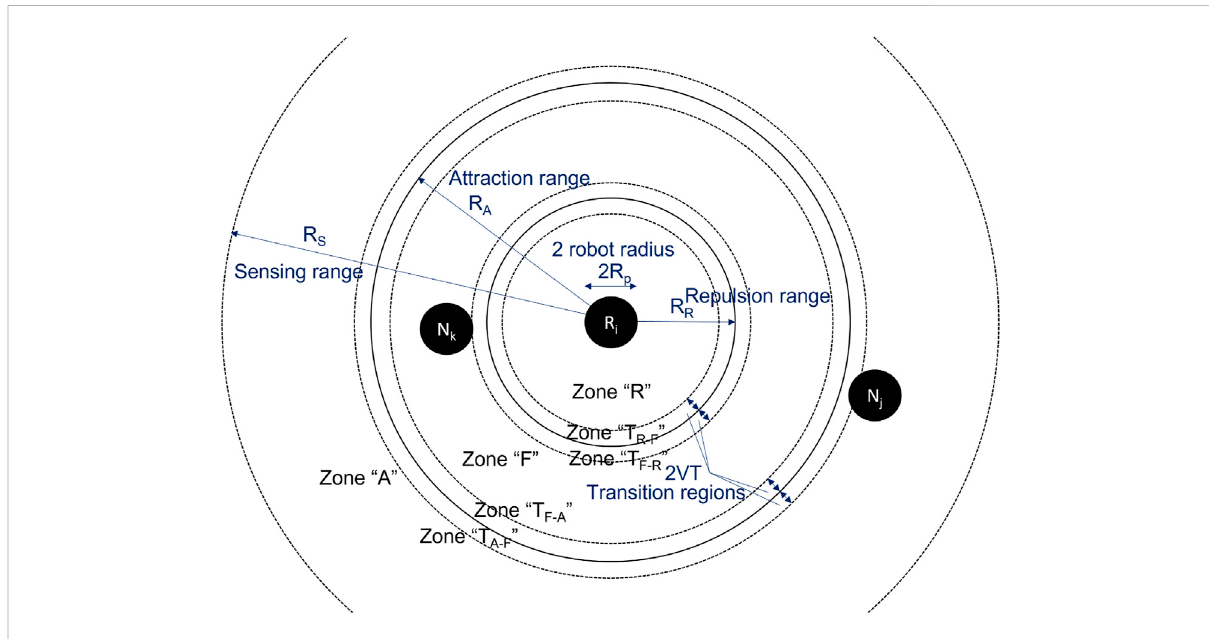
FIGURE 6 Spatial discretization used in μ M-C.